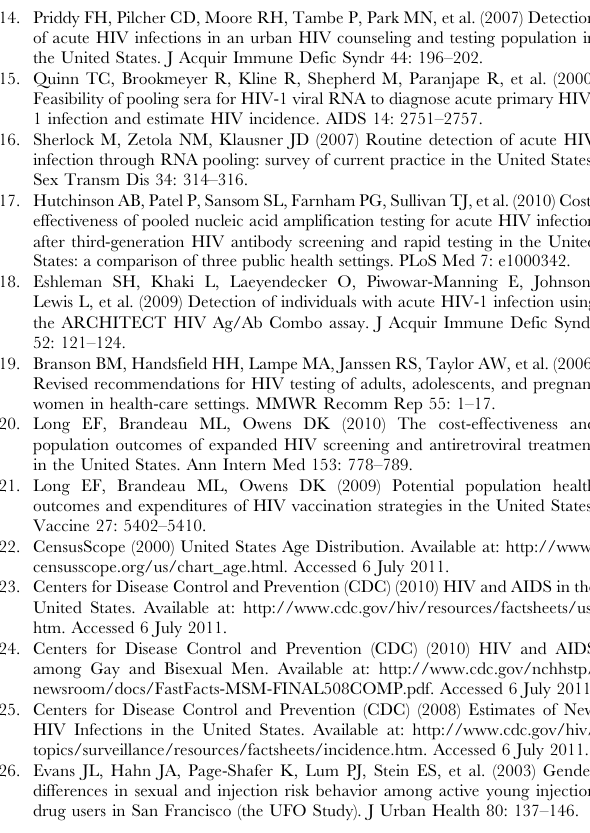
Figure S1 Schematic diagram of HIV transmission model and potential modes of transmission. The boxes represent cohorts of individuals in each disease stage and the arrows represent transitions due to disease transmission, disease progression, mortality, screening, or treatment initiation. ART = antiretroviral therapy. A description of each parameter is given in Table S2. (JPG) Figure S2 Window period of detection during acute HIV. The figure shows the duration (in days) of the acute infection period ( 1/ h ACUTE ), and the window period of detection for each test: nucleic acid amplification test ( v NAAT ), fourth-generation immunoassay ( v 4GEN ), and third-generation enzyme linked immunosorbent assay ( v 3GEN ). Table S1 Modes of HIV transmission. (PDF) Table S2 Summary of key model parameters.